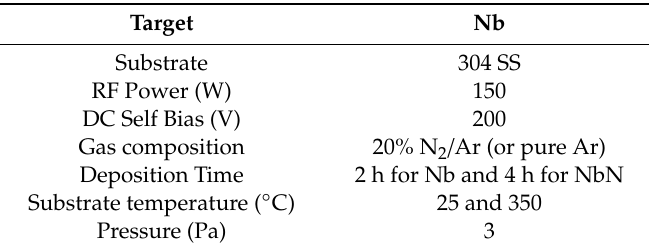
Table 1. Radio frequency (RF) sputtering parameters used for the deposition of Nb, NbN, and Nb / NbN